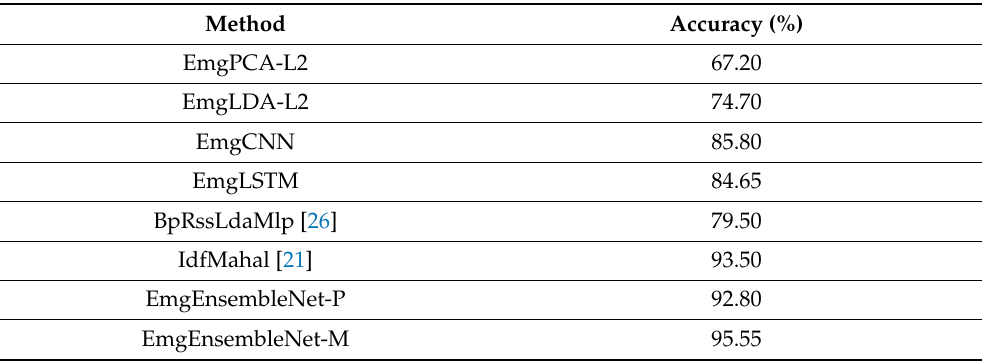
Table 4. Accuracies on Test data on Angeles EMG dataset.